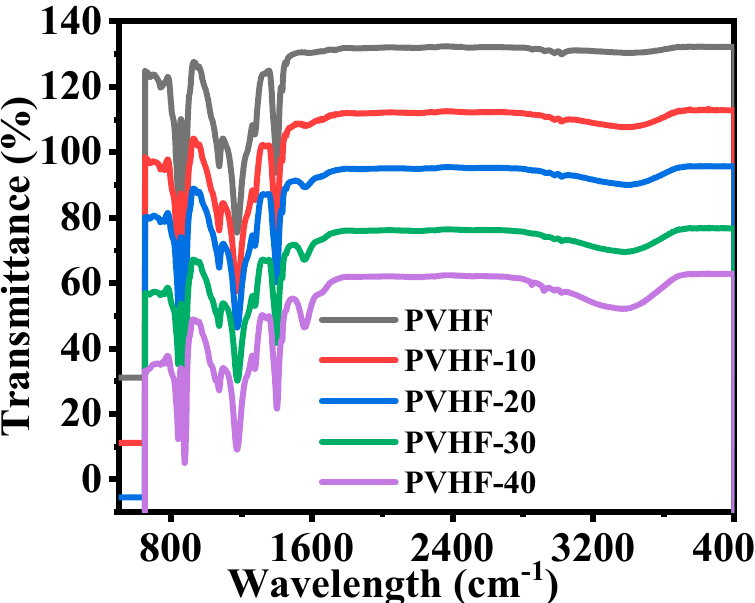
Figure 6. FTIR graphs of PVHF and Co@PVHF